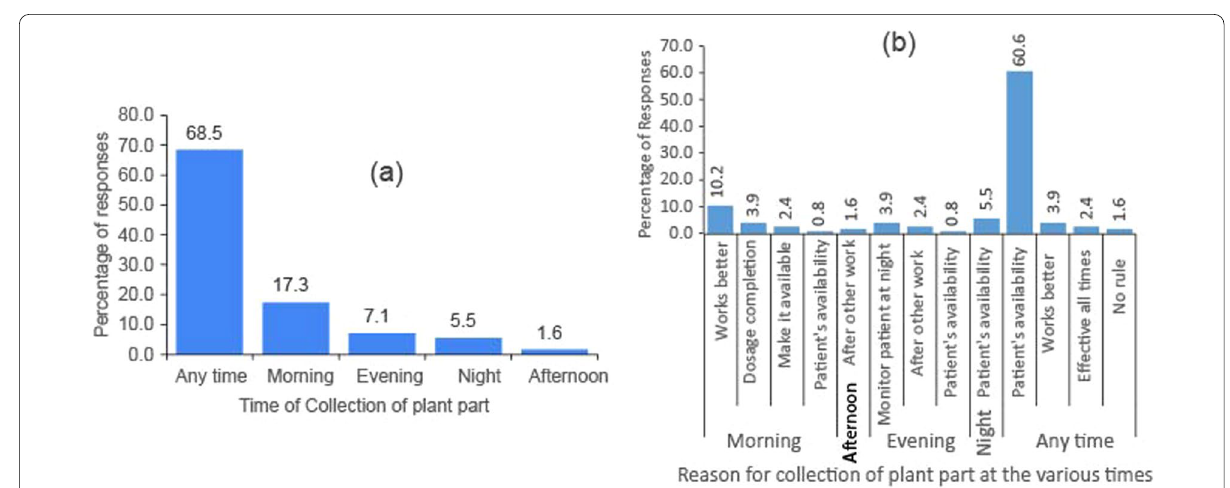
Fig. 4 Plant collection time ( a ) and reasons ( b